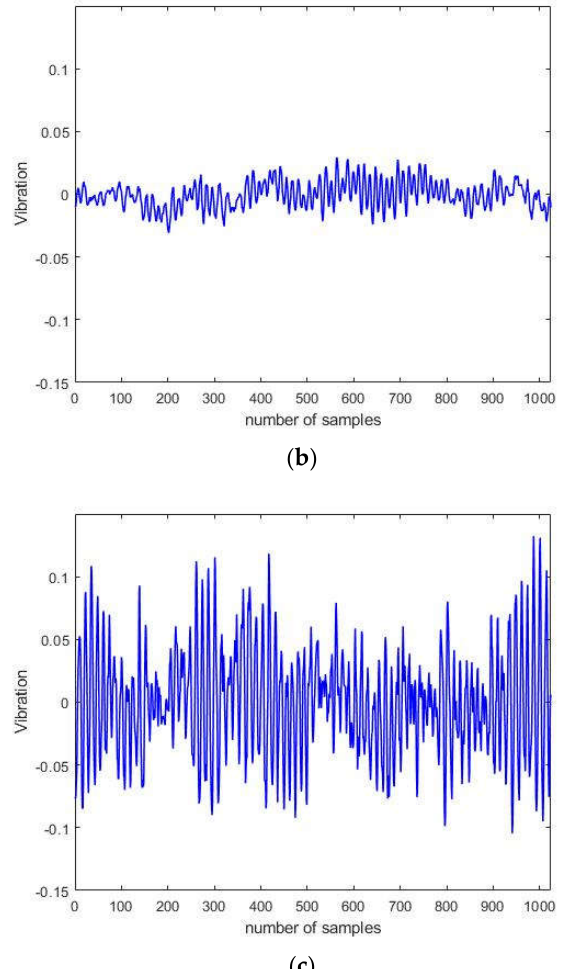
Figure 4. Data collected from the simulator. ( a ) Normal data. ( b ) Rotor fault data. ( c ) Bearing fault data.